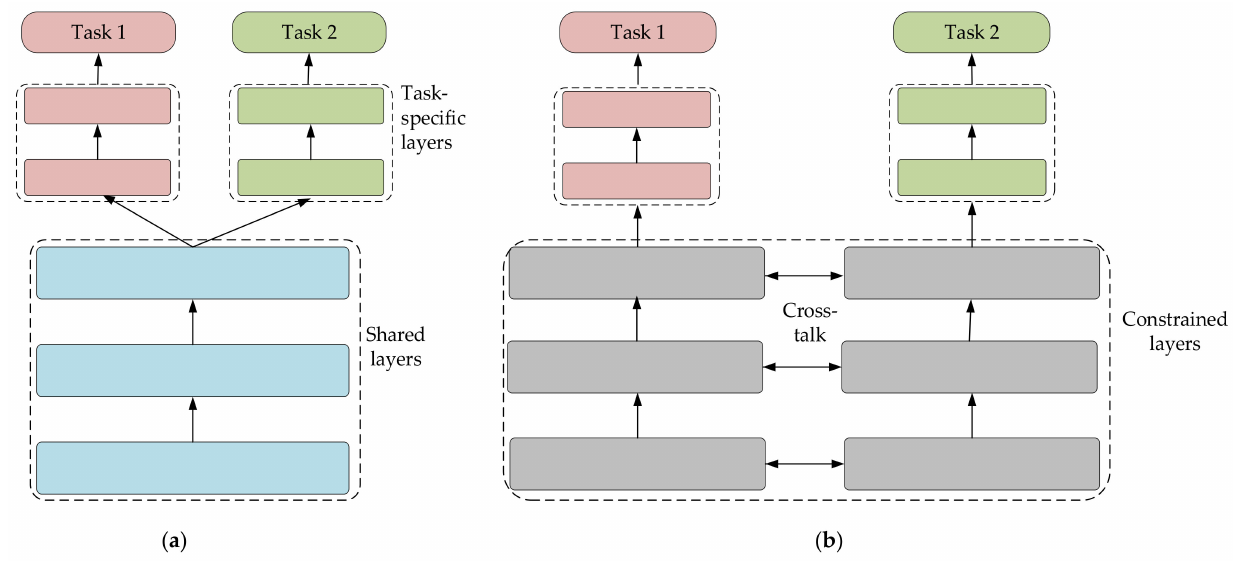
Figure 1. Two deep MTL architectures: ( a ) hard parameter sharing, and ( b ) soft parameter